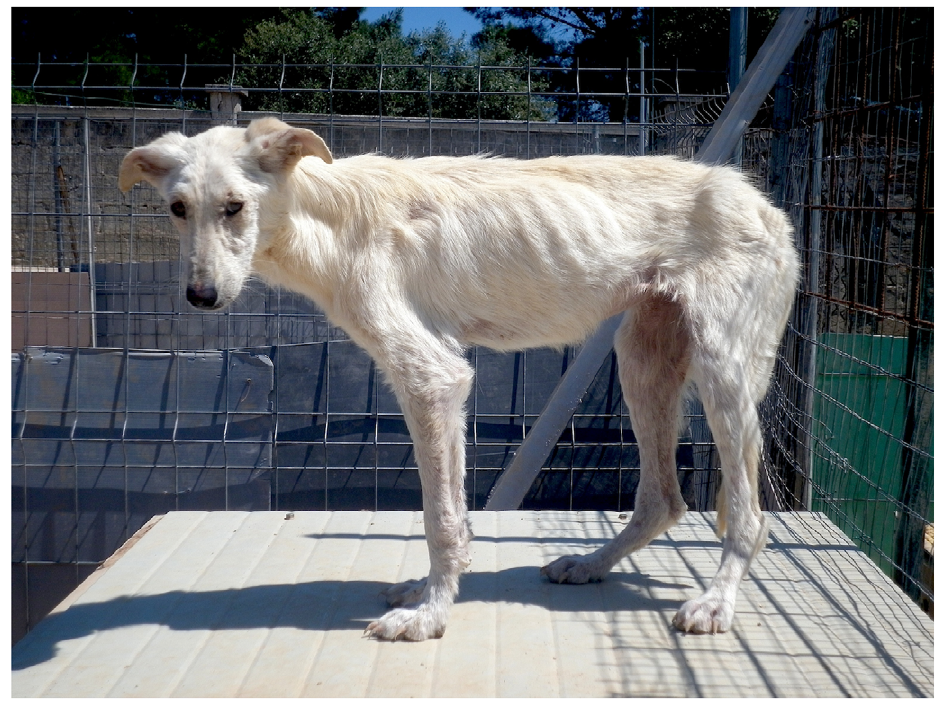
Figure 1. A dog from Group B displaying clinical signs of canine leishmaniosis.